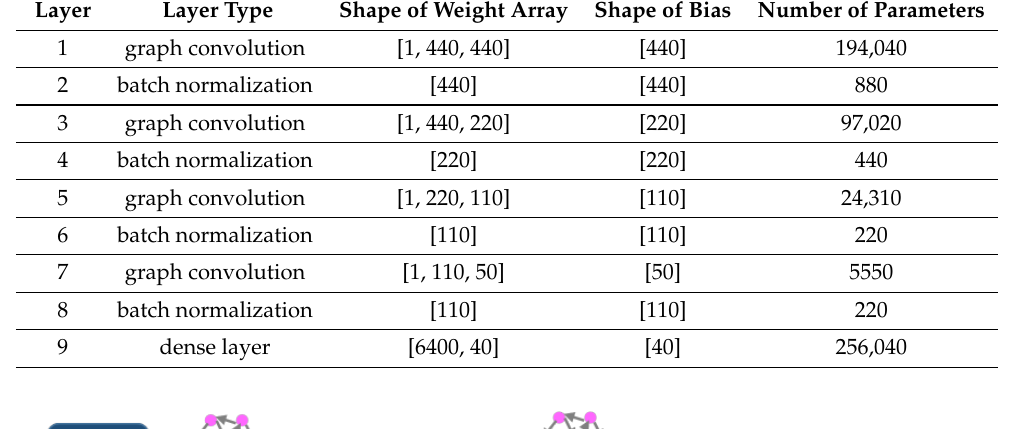
Table 1. Number of training parameters of the GDN part of the proposed GDN-GAN.